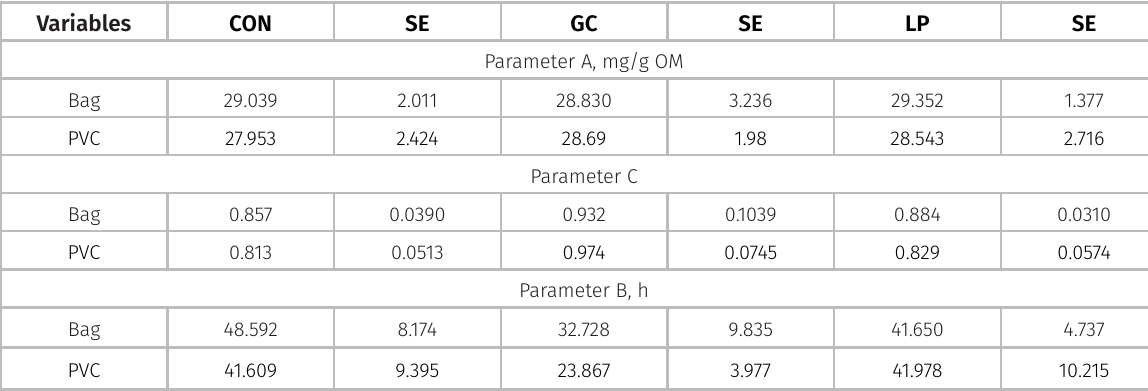
Table III. Effects of additives on gas production parameters of pearl millet silage. Variables